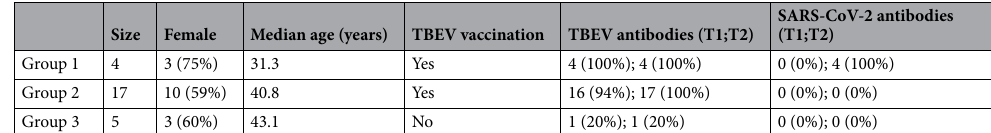
Table 2. Characteristics of 26 healthcare workers and their TBEV/SARS-CoV-2 serostatus at time points T1 and T2. SARS-CoV-2 Severe Acute Respiratory Syndrome Coronavirus-2, TBEV Tick-Borne Encephalitis